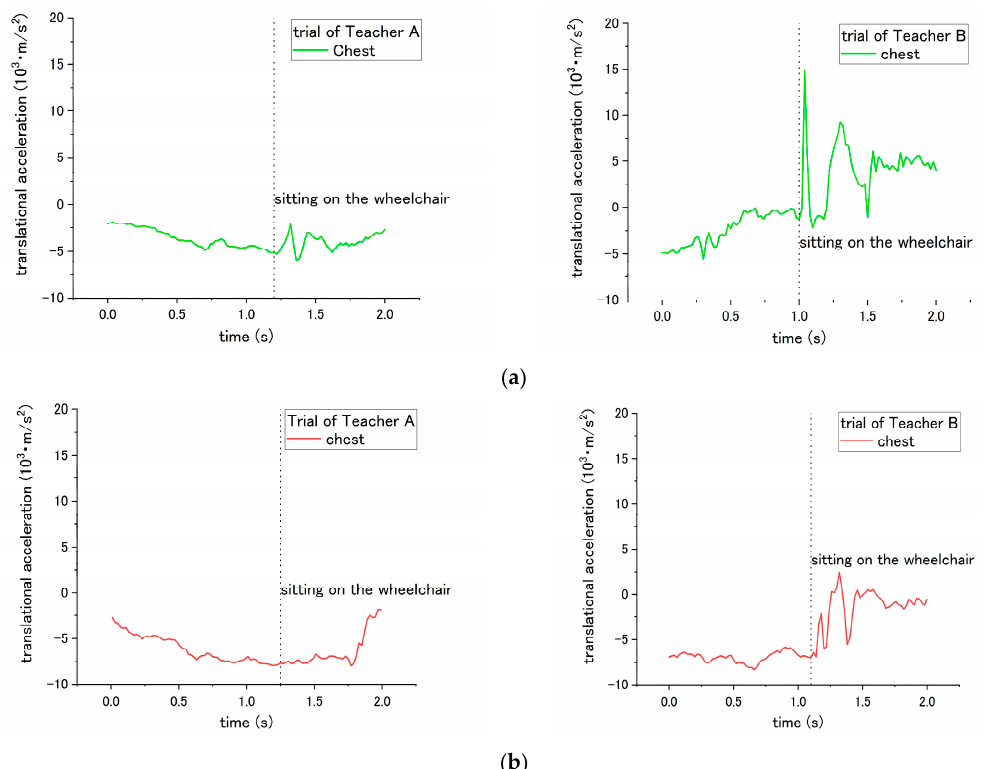
Figure 6. Translational acceleration of patient’s waist during step No. 15 under ( a ) correct way, and ( b ) incorrect way conducted at step No. 3.